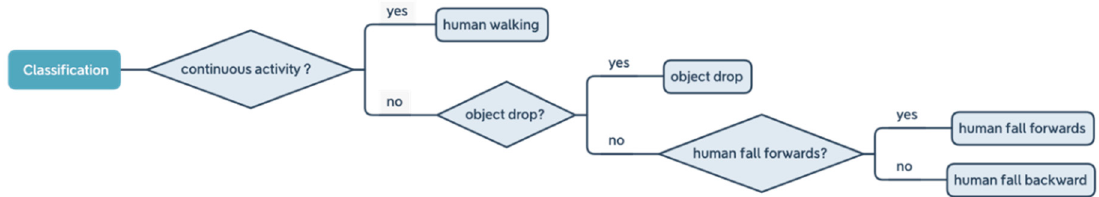
Figure 15. Work flow for the classification